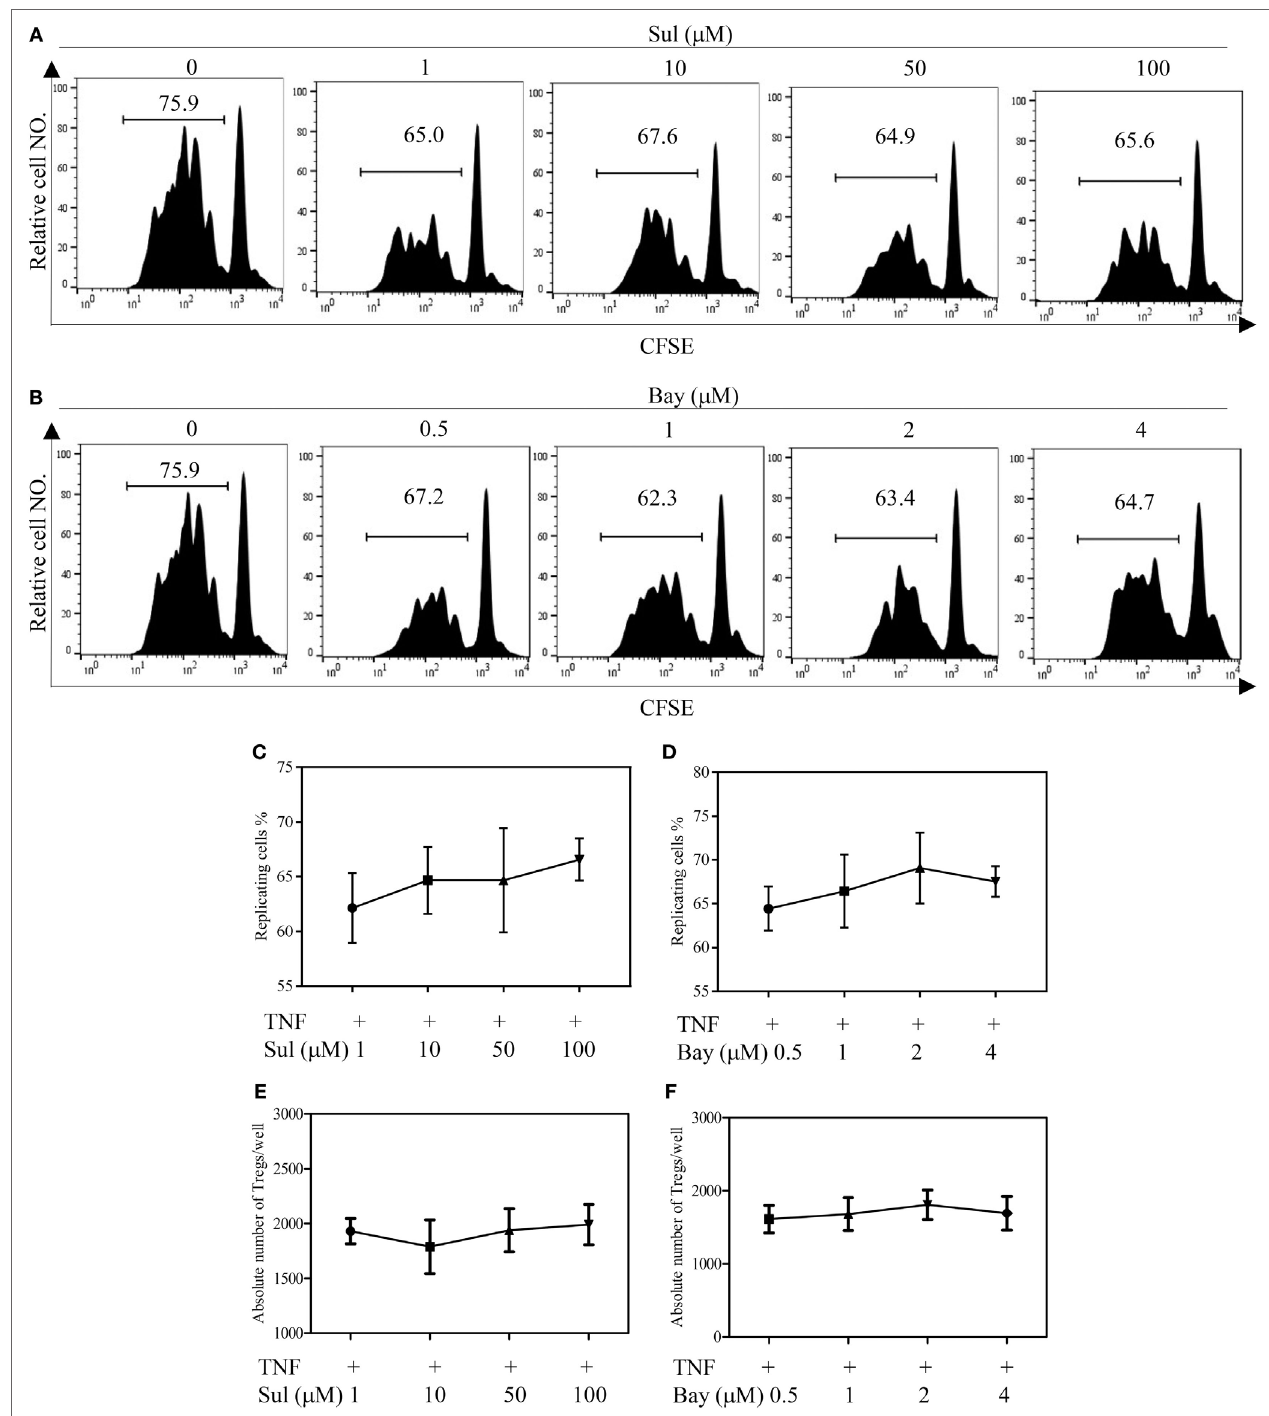
FigUre 2 | Effect of NF- κ B inhibitors on tumor necrosis factor (TNF)-mediated proliferative expansion of regulatory T cells (Tregs). CD4 + cells were purified from LNs and spleen of normal C57BL/6J mice by MACS. The cells were labeled with CFSE and cultured in the presence of IL-2 (10 ng/mL), or IL-2 + TNF (10 ng/mL, each), with medium alone or with different concentrations of Sulfasalazine (Sul, 1, 10, 50, 100 µM) or Bay 11-7082 (Bay, 0.5, 1, 2, and 4 µM). After 72 h, the proliferation of Tregs and the absolute number of Foxp3 + cells were analyzed by FACS, based on CFSE expression and Foxp3 expression. (a,B) Typical FACS analysis of Treg proliferation, as shown by dilution of CFSE expression (gating on Foxp3 + cells). The number in the histogram indicates the proportion of gated cells, e.g., replicating cells (%). (c,D) The summary of proportion of replicating Tregs. (e,F) The absolute number of Treg cells per well. Data shown in (c–F) are representatives of at least three separate experiments with similar results ( N = 3, means ±